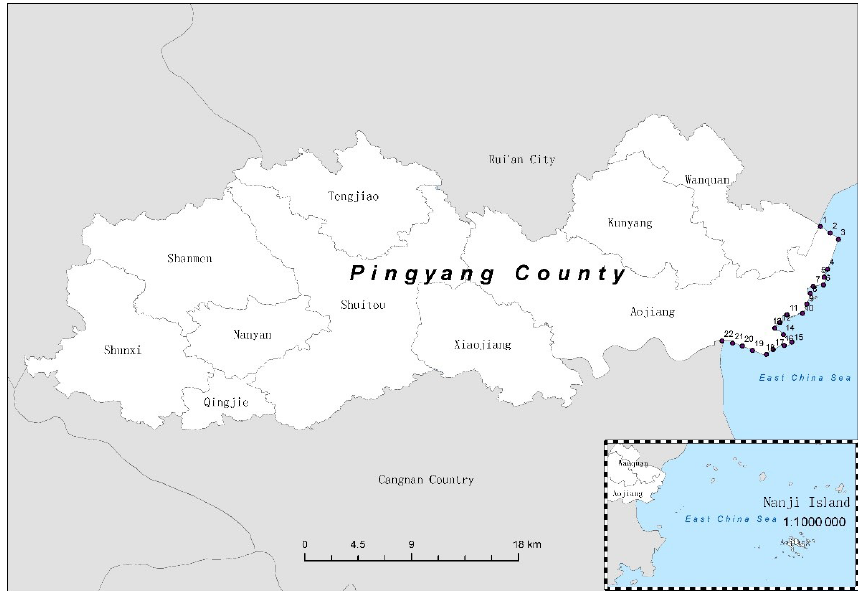
Figure 11. The reference points along Pingyang coast.